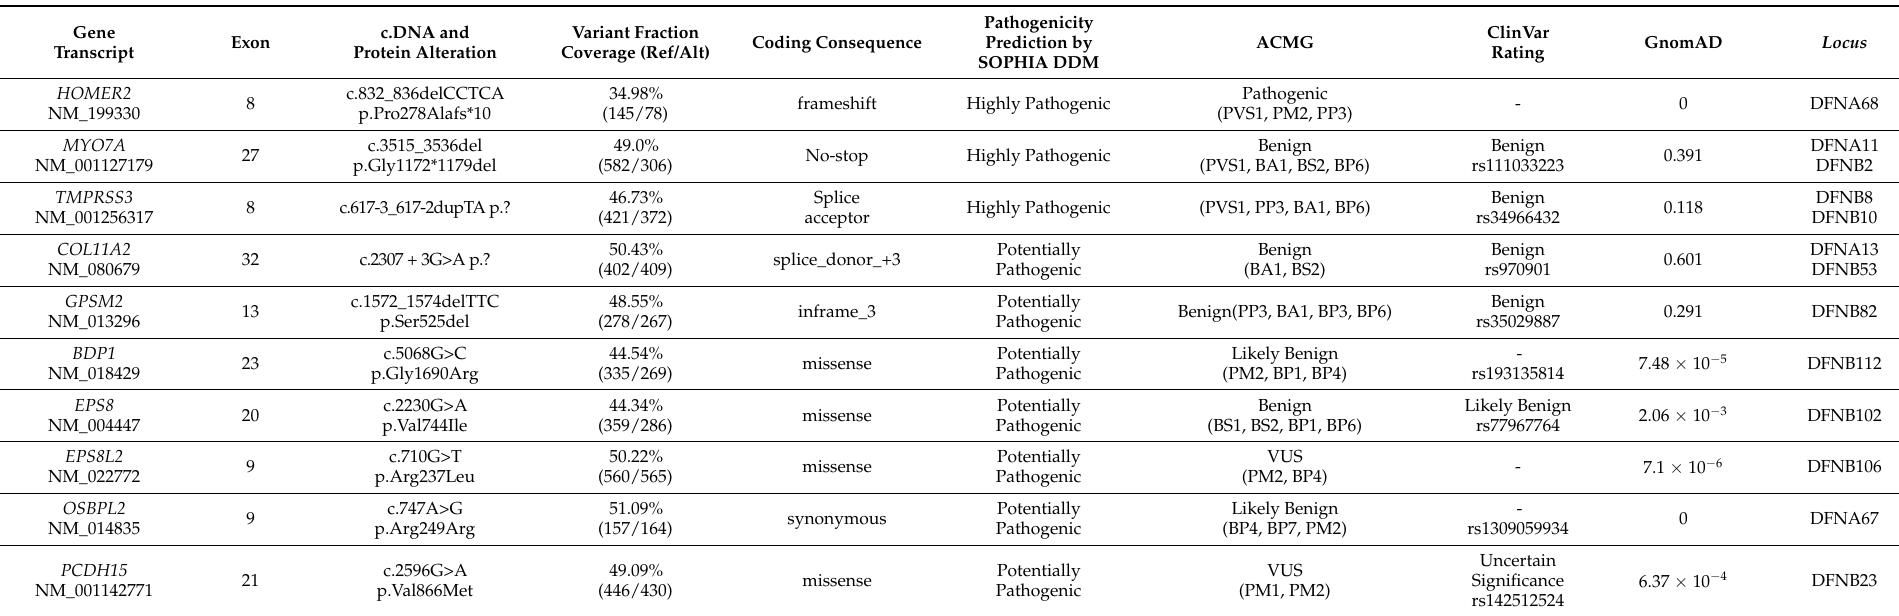
Table 1. Genetic variants with potential pathogenicity identified by SOPHIA DDM software in the index case (II:2) of family S1074.